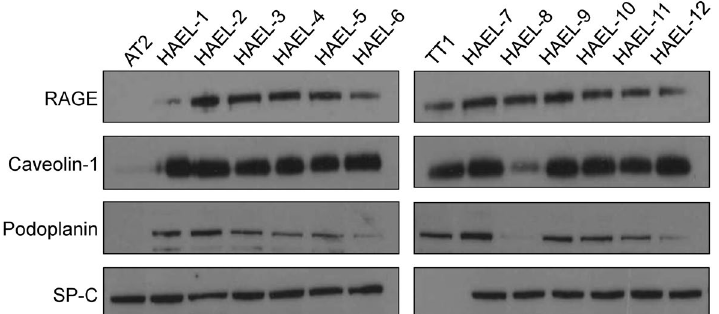
Figure 3. Immunoblotting analysis of RAGE, caveolin-1, podoplanin and SP-C in ICs, TT1 cell line and primary AT2 cells. Loading protein concentrations were adjusted to 50 μg per sample.